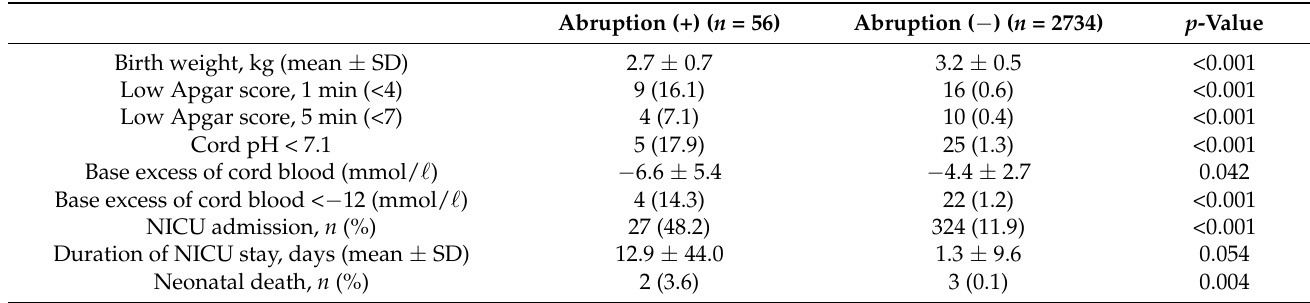
Table 2. Neonatal outcomes according to placental